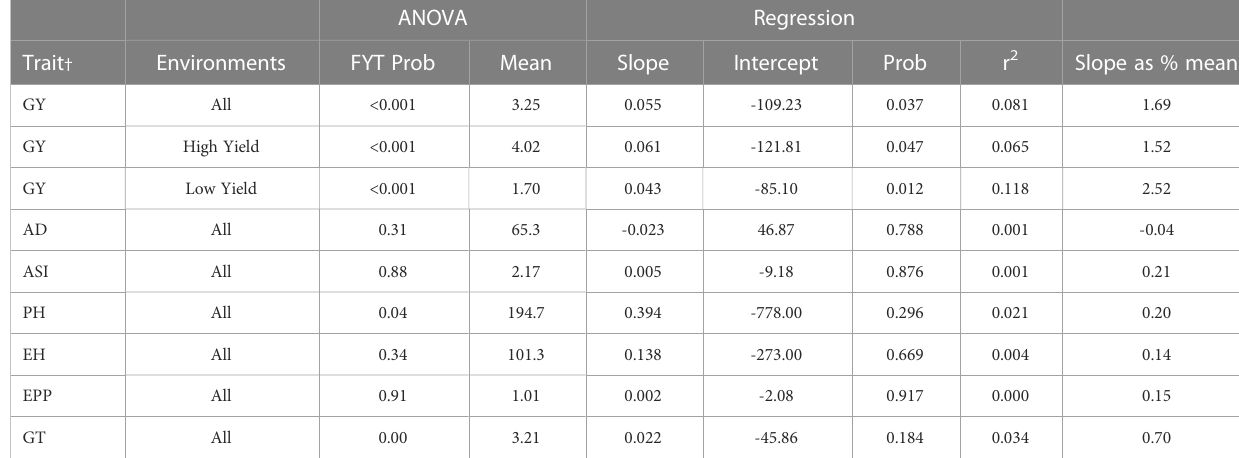
TABLE 8 Results from ANOVA and regression analyses of the era trial conducted at six locations in 2015.